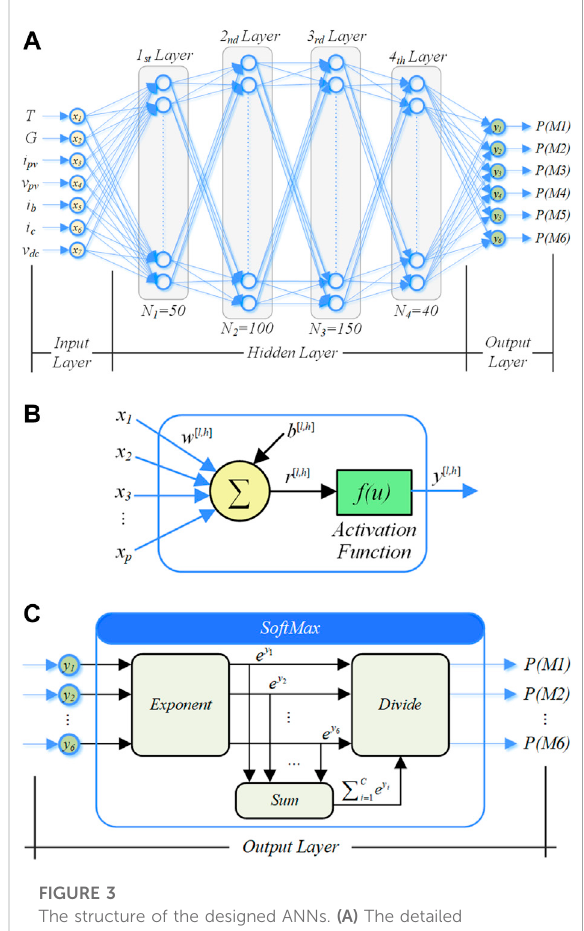
FIGURE 3 The structure of the designed ANNs. (A) The detailed structural information of the neural network. (B) The neural node structure. (C) The structure of SoftMax in the output